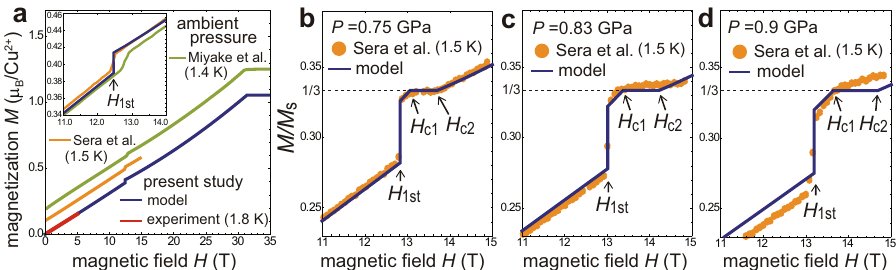
Fig. 7 Magnetization curves. Theoretical magnetization curves obtained by the 1/ S expansion method 15 with the “ cutting-at-1/3 ” procedure 18 using the model parameters J 0 ( P ), Δ 0 ( P ), and J 1 ( P ) at temperature T = 0 for P = 0, 0.75, 0.83, 0.9 GPa, together with the corresponding experimental data of the present measurements at T = 1.8 K, Miyake et al. at T = 1.4 K (for increasing fi elds) 41 , and Sera et al. at T = 1.5 K 10 . In a the curves are vertically shifted by 0.1 from one another to avoid overlapping. The inset shows the enlarged view of the transition region with no vertical shift. In b – d , the magnetization scaled by the saturation value M s is plotted. Correspondingly, the curves of Sera et al. are scaled such that the plateaux are located at M = M s /3.